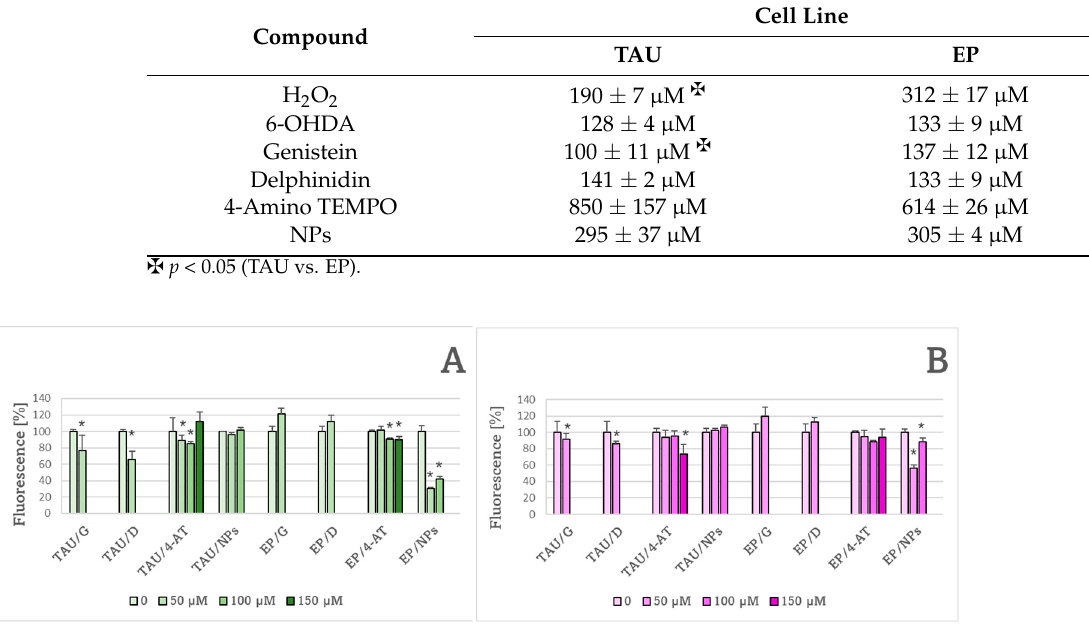
Table 1. Concentrations of compounds inducing 50% cytotoxicity (IC 50 ) of TAU- and EP-transfected cells. Cell Line Compound TAU EP  p < 0.05 (TAU vs EP). H 2 O 2 190 ± 7 µ M (cid:122)